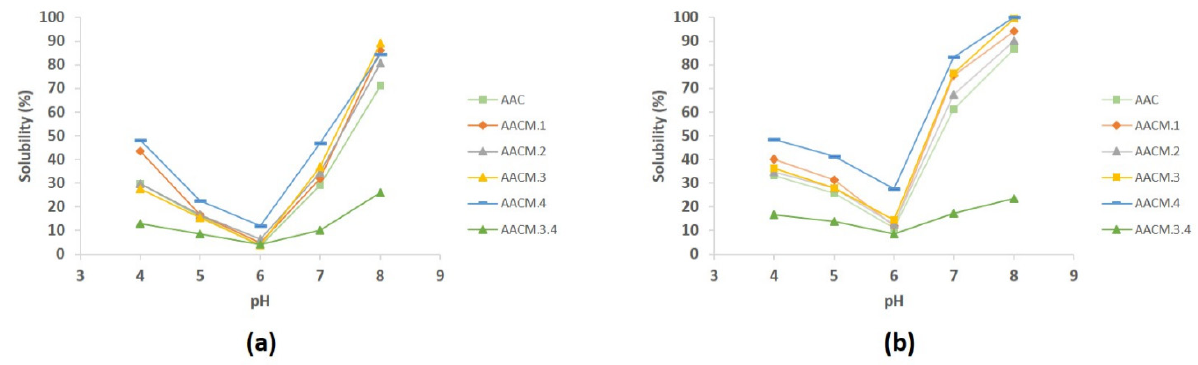
Figure 2. Solubility of AAC and their modified polypeptides at low ionic strength ( a ) and high ionic strength ( b ) at different pH conditions. AAC, light green; AACM.1, orange; AACM.2, gray; AACM.3, yellow; AACM.4, blue; AACM.3.4 dark green. The results obtained are the mean of triplicate assays.